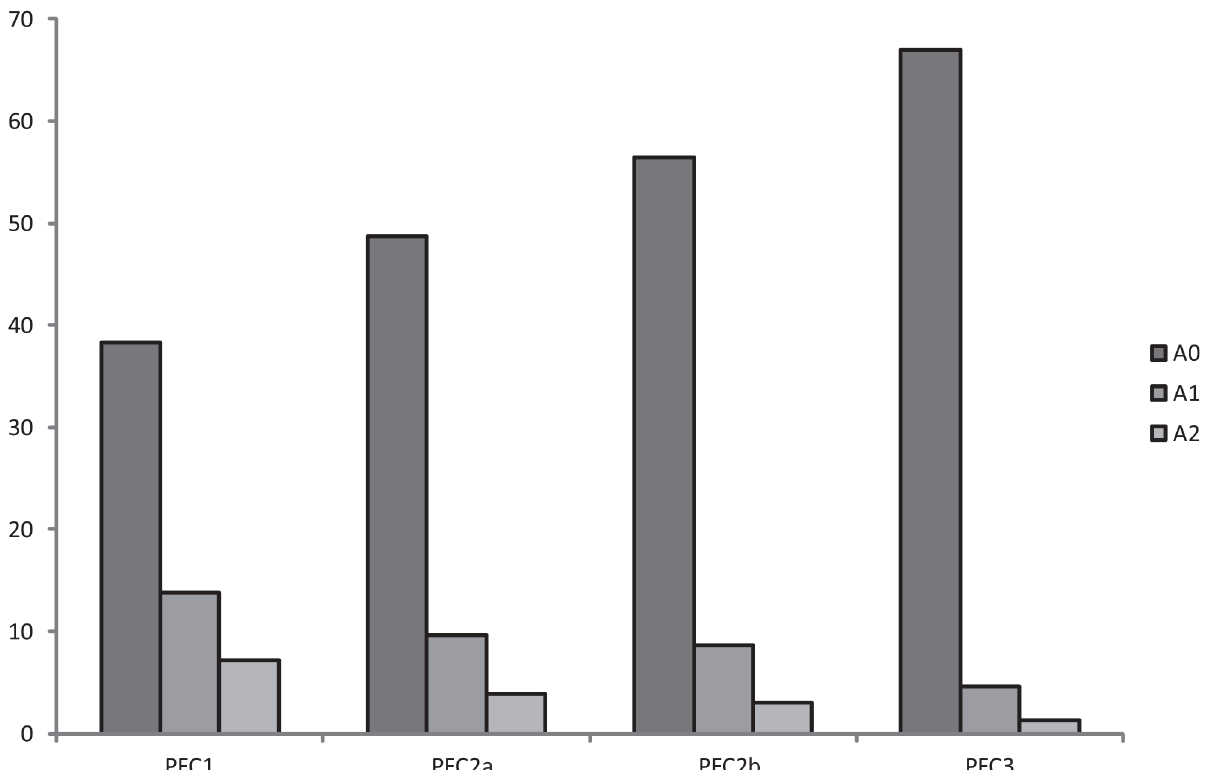
Fig 3. Graph of the mean values of each Fourier component for each phenological fuel class (PFC). The first (A1), and the second (A2) Fourier component represent the vegetation seasonality trend; the additive term (A0) expresses the vegetation productivity. The y-axis is in arbitrary units.